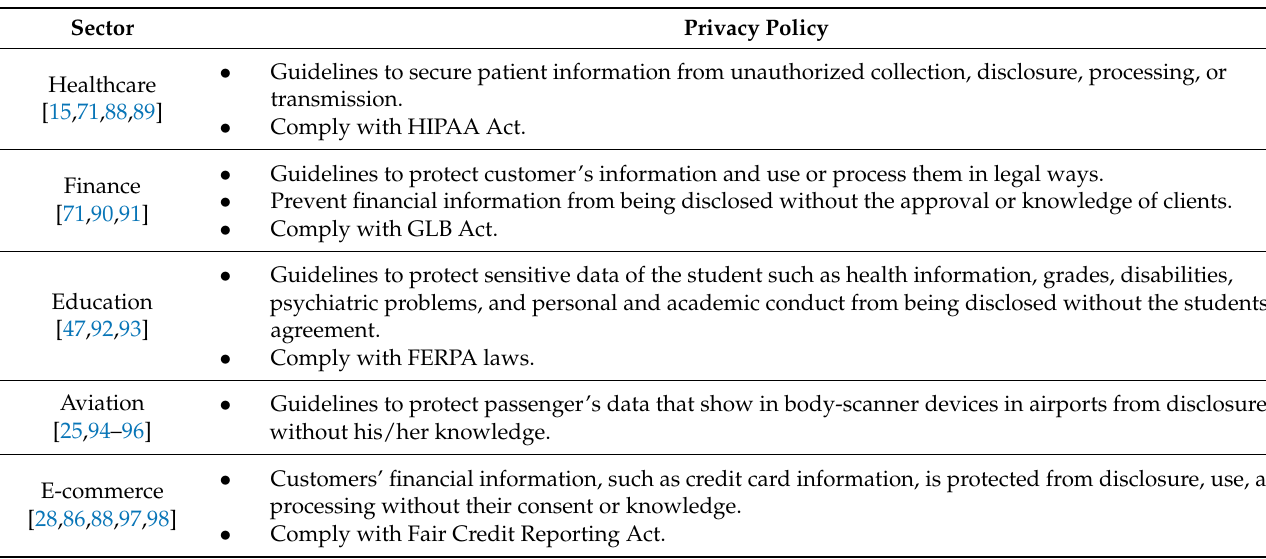
Table 2. Privacy policy among different